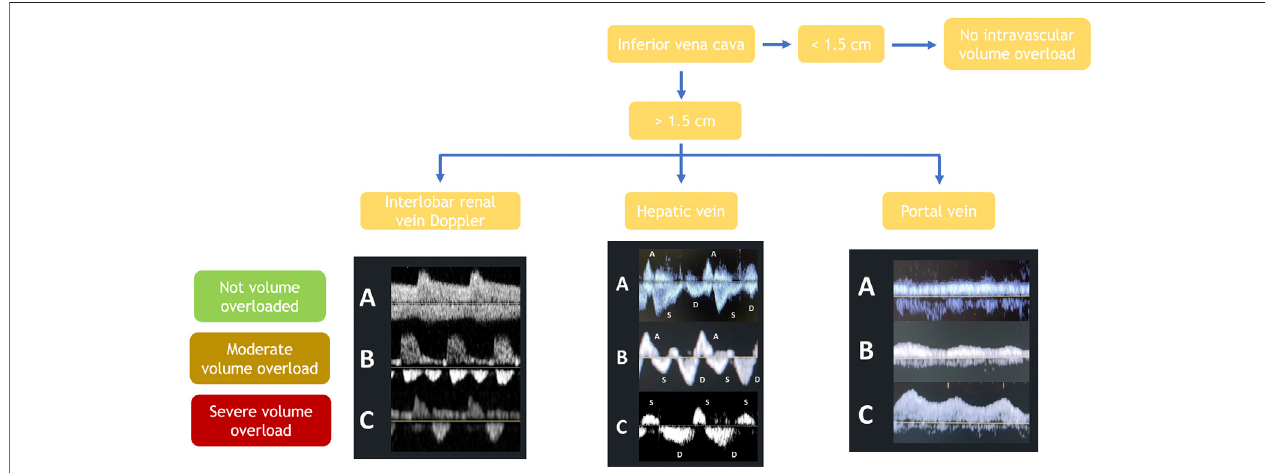
FIGURE2| Abdominalultrasound-guideddiagnosisofvolumestatusanditsseveritybyassessingtheinferiorvenacava ’ sdiameter,followedbyDopplerevaluation of portal, hepatic and renal interlobar vein waves.